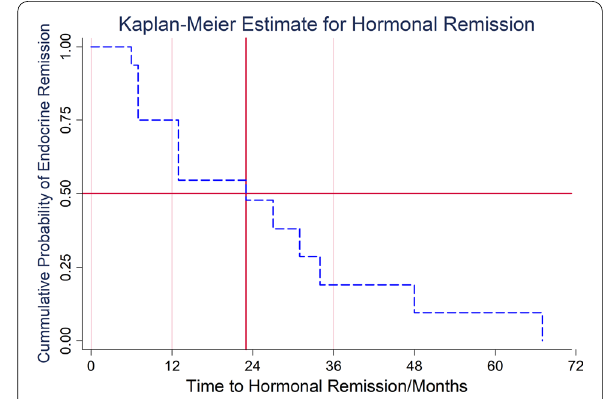
Fig. 1 Kaplan–Meier curve for hormone normalization